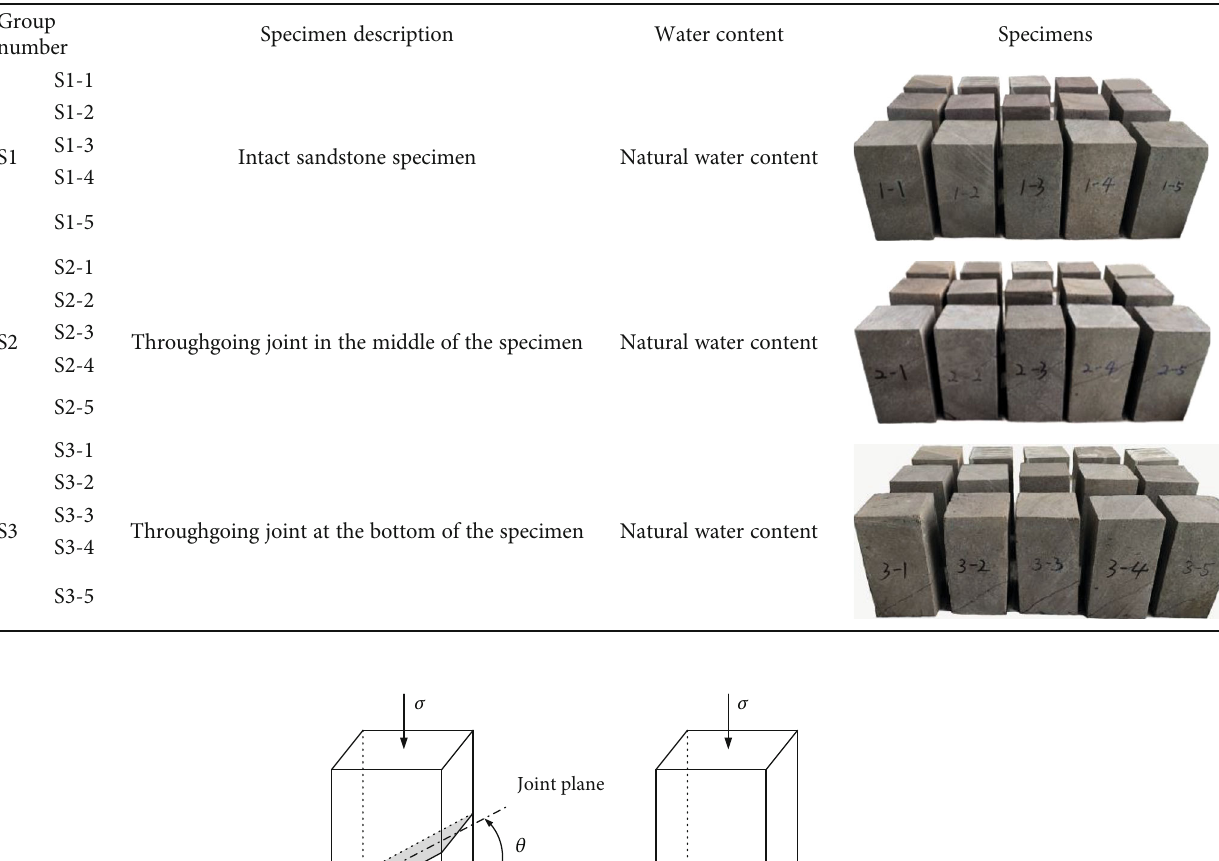
Table 1: Specimen preparation scheme.